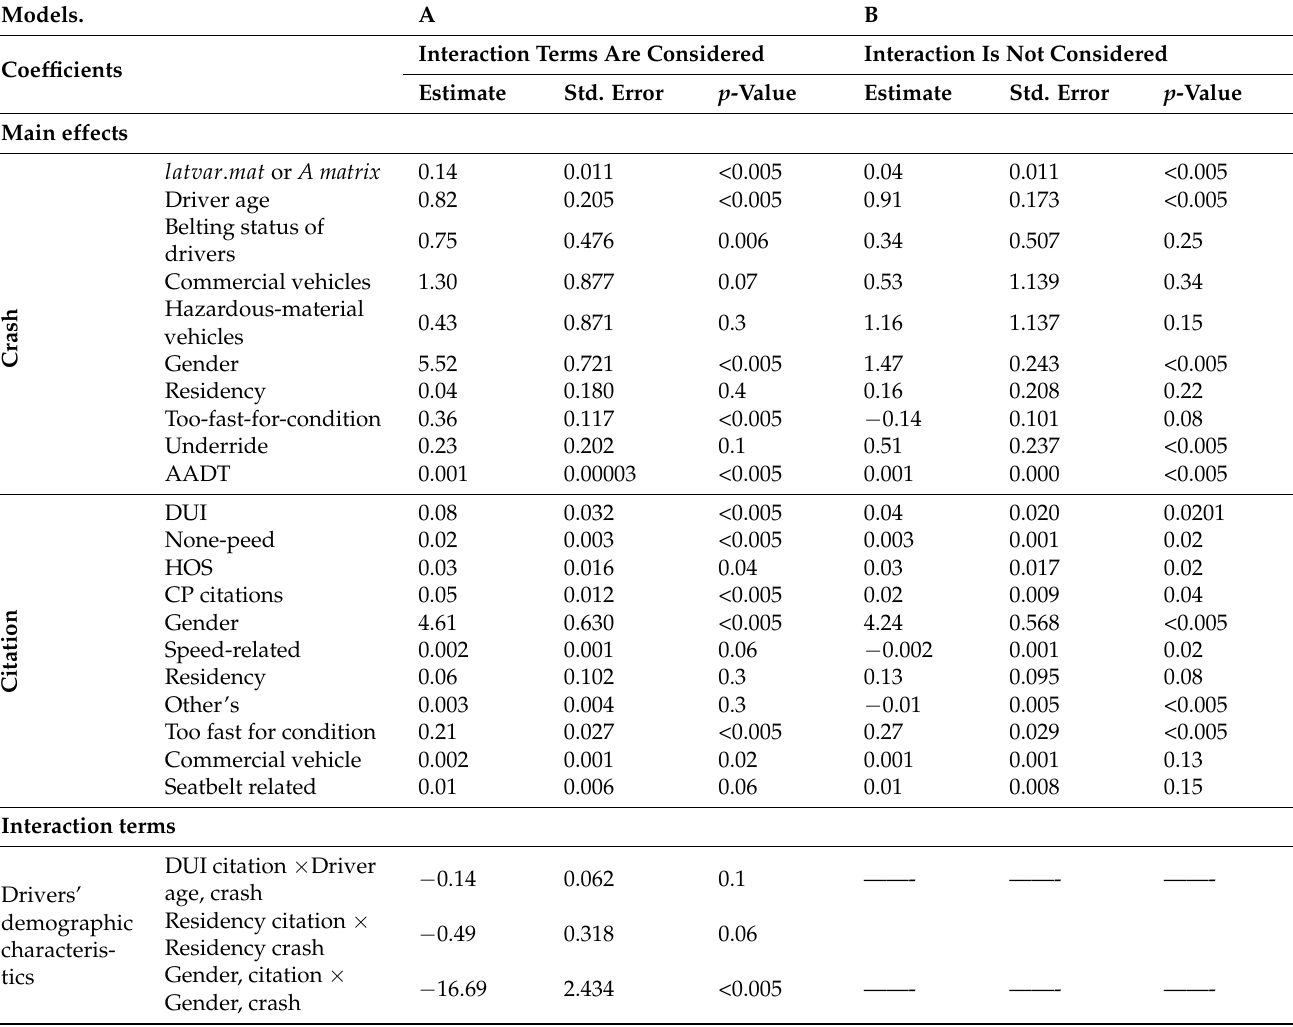
Table 2. Estimated parameters of the RRR, considering interaction terms and no interaction